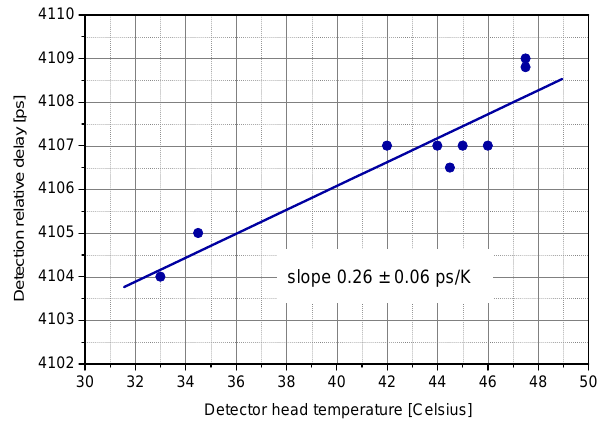
Figure 13. Temperature dependence of detection delay [20] for typical chip and active quenching circuit with the built-in temperature